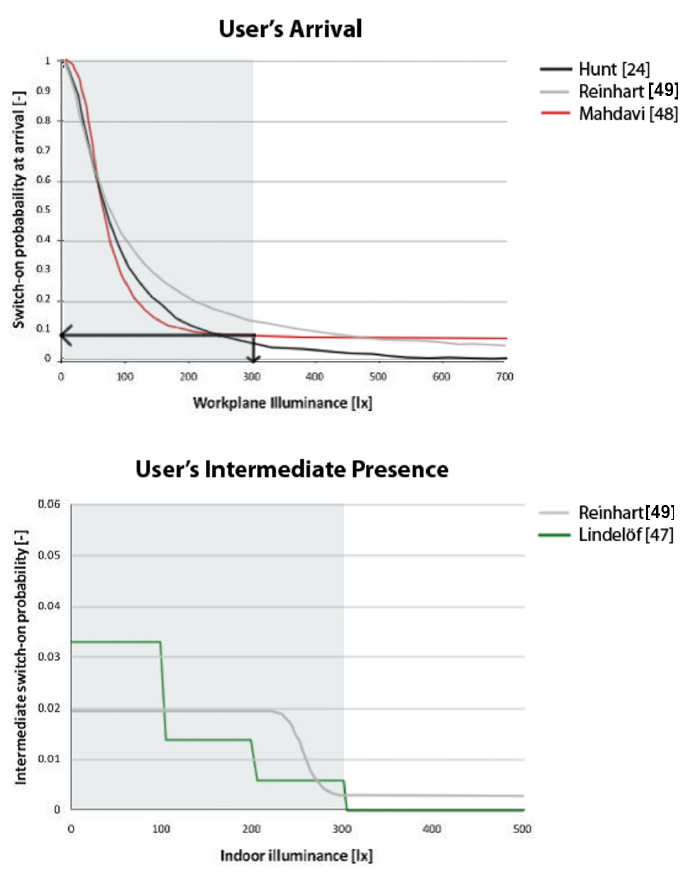
Figure 1. Comparison of probability functions of switching the lights on at users’ arrival and intermediate presence, adapted from [49].